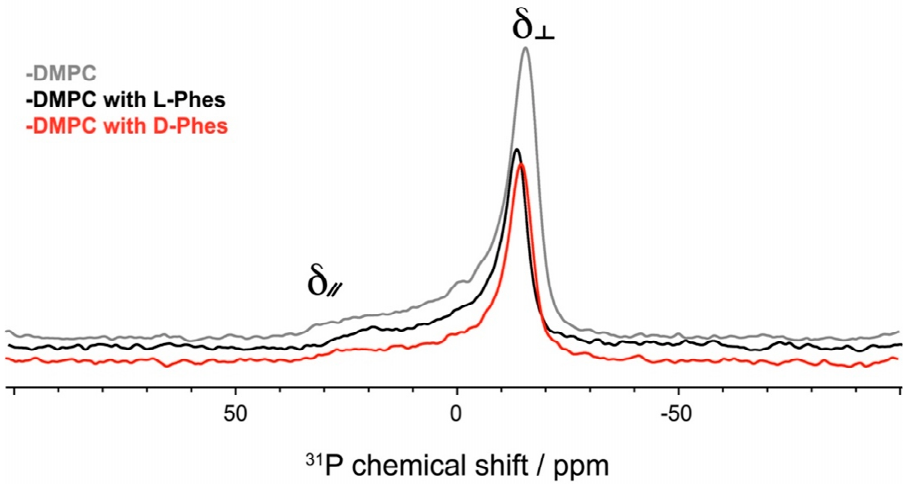
Figure 3. 31 P solid-state NMR spectra of DMPC (grey), DMPC with L-Phes (black), and DMPC with D-Phes (red) under static condition.